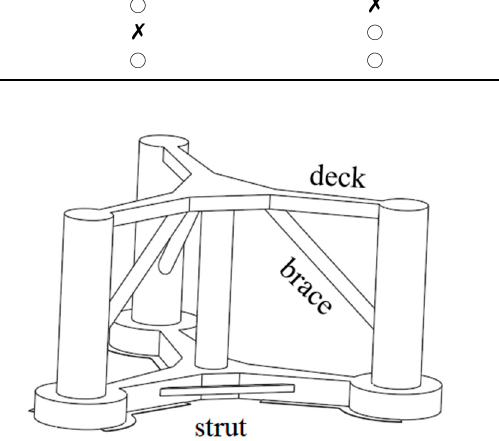
Figure 13. Overview of the platform with brace, deck and strut.